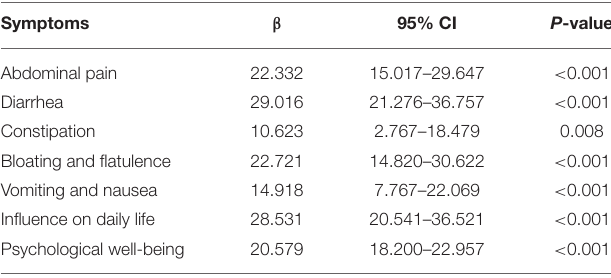
TABLE 2 | Associations between gastrointestinal symptoms the past 2 weeks and having